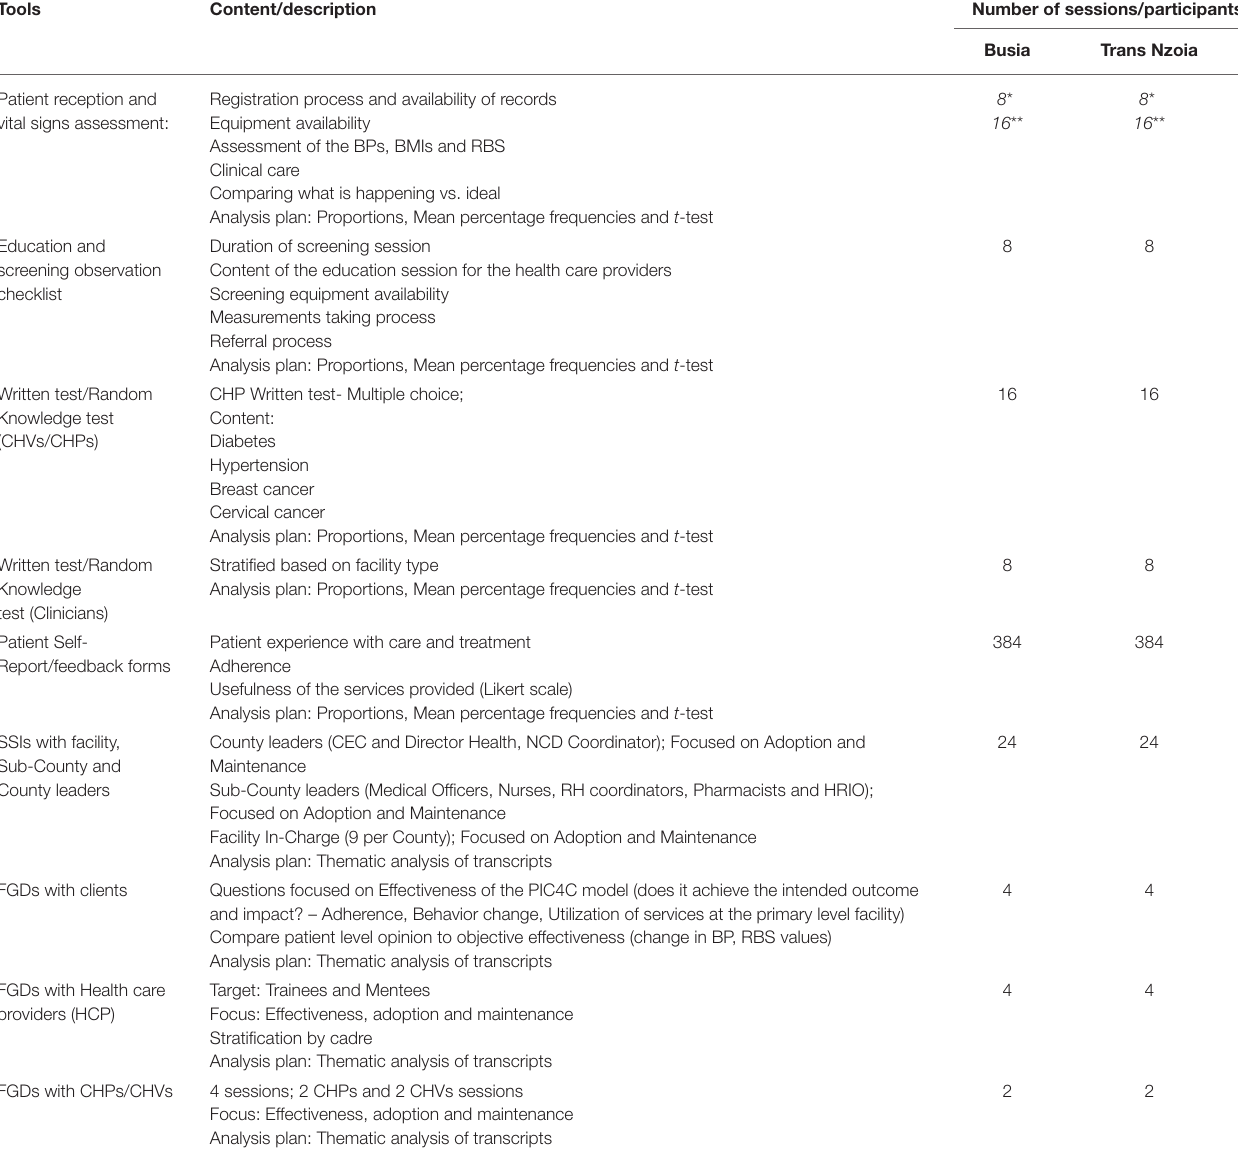
TABLE 4 | PIC4C process evaluation study participants, tools and analysis plan.